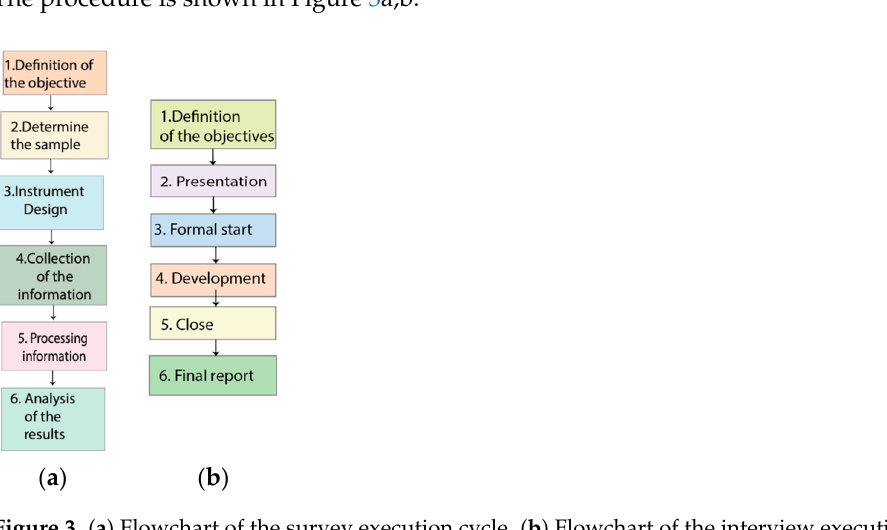
Figure 3. ( a ) Flowchart of the survey execution cycle. ( b ) Flowchart of the interview execution